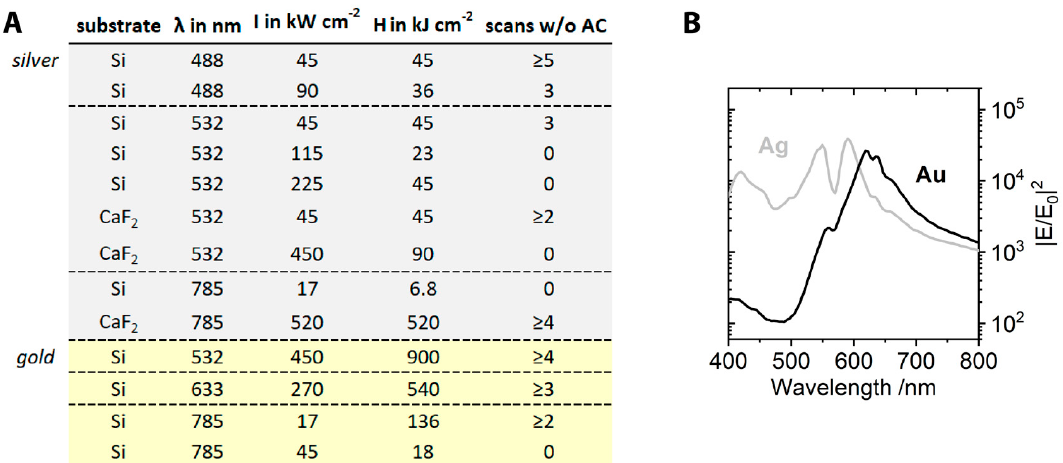
Figure 3. ( A ) Measurement conditions for silver and gold dimers and number of scans before any amorphous carbon (AC) background was observed. λ —irradiation wavelength, I—irradiation power density, H—irradiation energy density. ( B ) Maximal electromagnetic field intensity enhancement of 60 nm gold and silver dimers with a gap of 3 nm, determined by FDTD simulations including the DNA coating and a silicon surface with a 2 nm silicon oxide